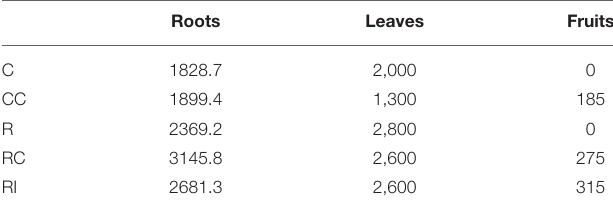
FIGURE 2 | Effect of soil management practices on trunk collar diameter growth of kiwifruit plants measured at different days after mid bloom (DAMB). (A) Total diameter increase; (B) average daily diameter growth rate. C, Control; CC, Control + Compost; R, Ridged; RC, Ridged + Compost; RI, Ridged + Inoculum. Different letters mean significant differences ( p < 0.05). TABLE 1 | Biomass (total roots, leaves and fruits; g, fresh weight) produced by a single plant, chosen as representative for each treatment, uprooted at the end of the third growth